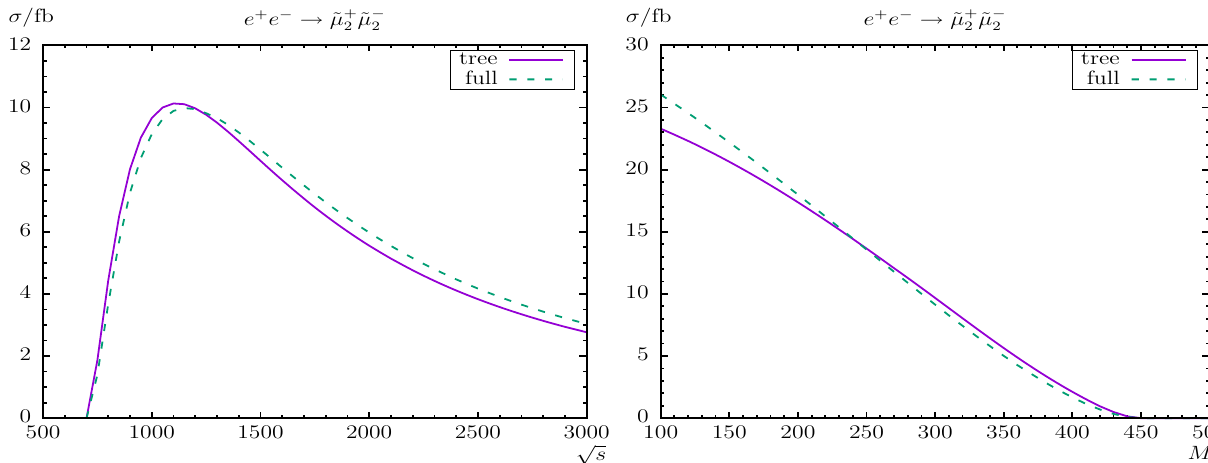
˜ μ − ) . Tree-level and full one-loop corrected cross sections are shown with parameters chosen according to S ; see Table 1. Fig. 14 σ( e + e − → ˜ μ + √ 2 2 s (left) and M ˜ The plots show the cross sections with (right) varied. All masses and energies are in GeV E